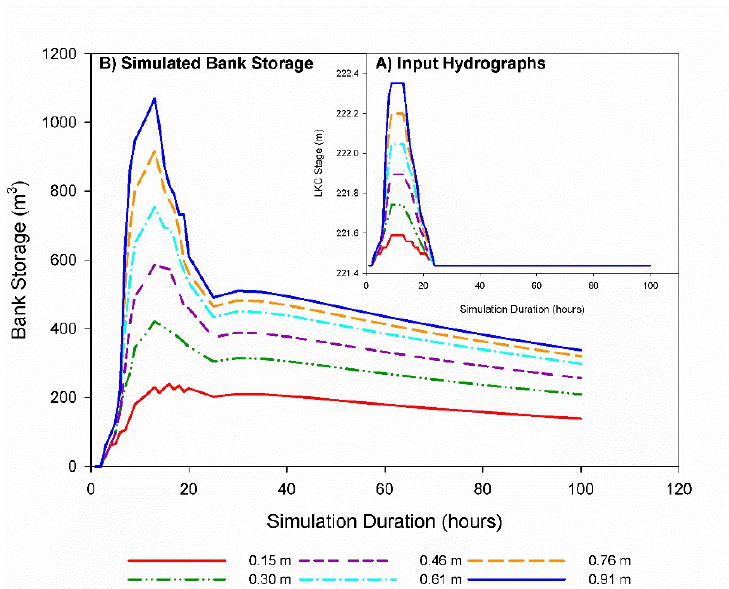
Figure 5. ( A ) (Inset) Input hydrographs used in numerical simulations. ( B ) Simulated bank storage for